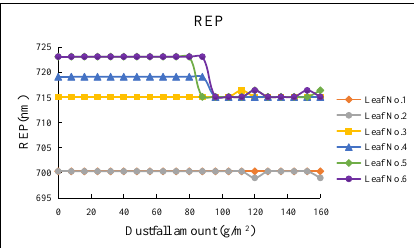
Fig. 3. REP varies with dustfall